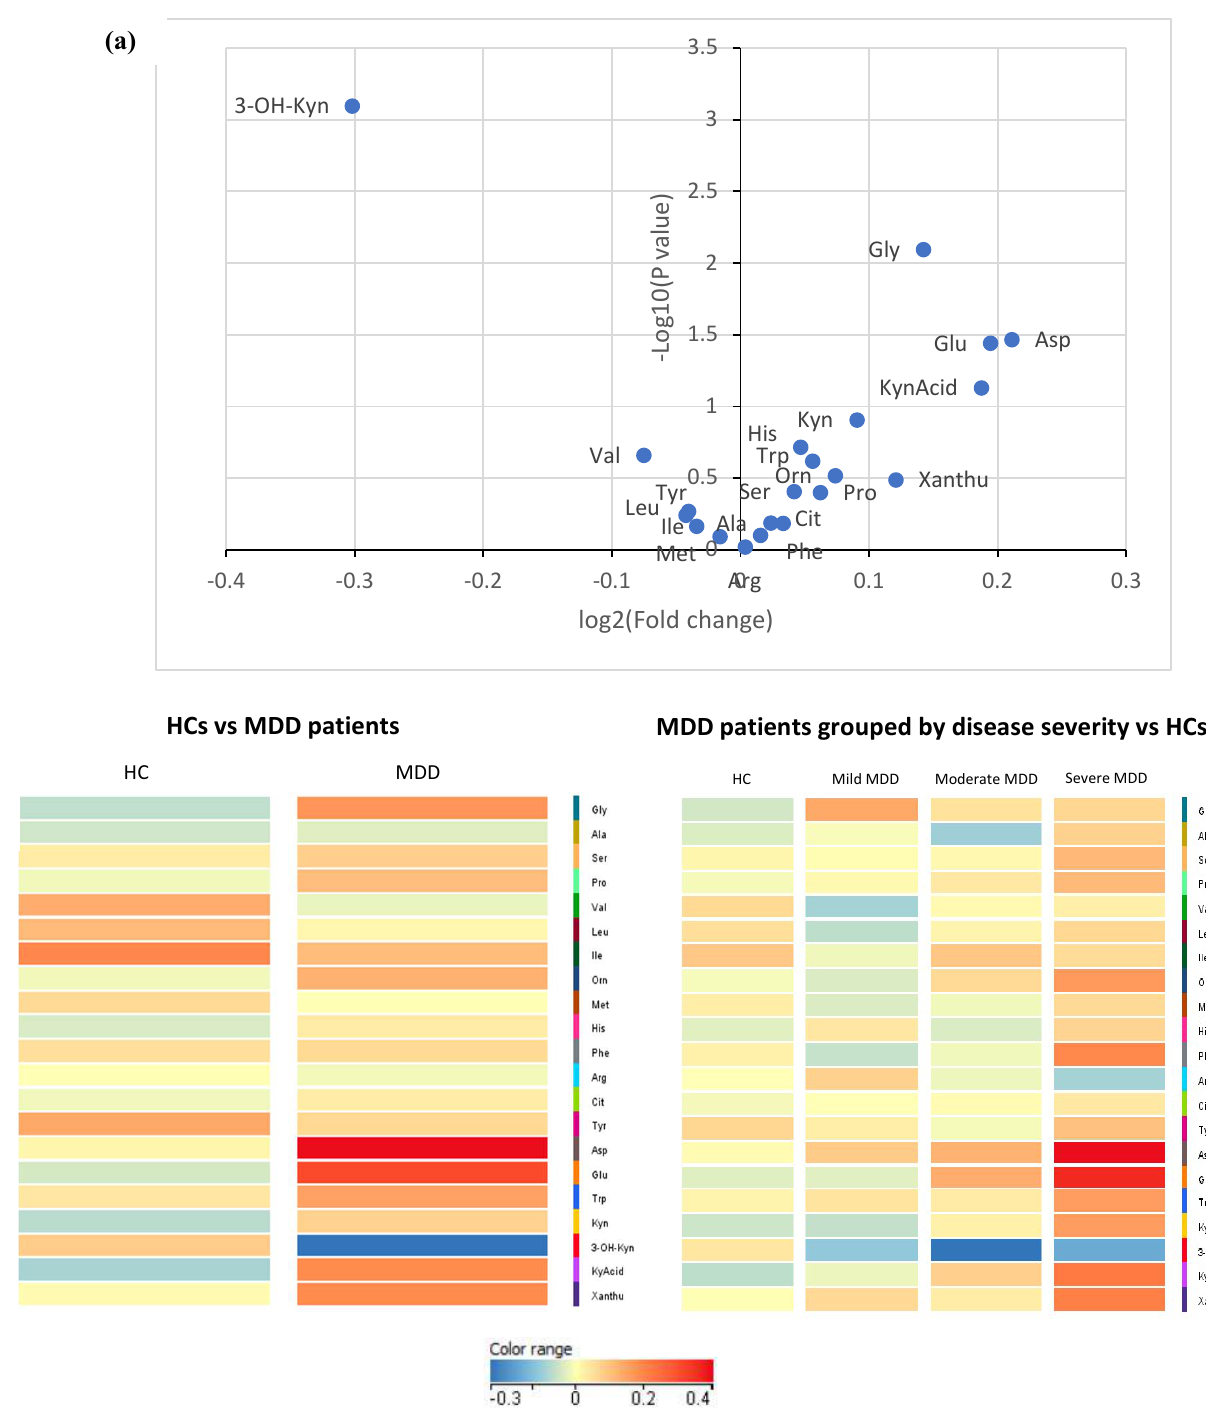
Figure 2. ( a ) Volcano plot comparing metabolite concentrations between MDD patients (n = 70) and HCs (n = 70). A larger difference in concentration for a particular amino acid would result in a higher log 2 (fold change) value, and a point that lies more towards the right side of the x-axis. The more significant the difference in concentration, the smaller the p value and, resultingly, the higher the log 10 ( p value). ( b ) Heat maps comparing metabolites between MDD patients (n = 70) and HCs (n = 70). Colour intensity represents fold change values, with red representing an increase and blue, a decrease.